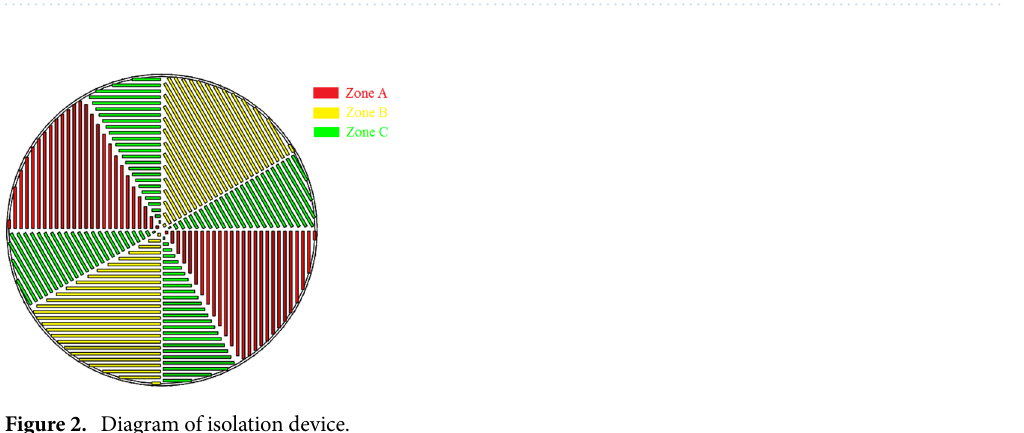
Figure 1. Model and mesh diagram of AlN-HT-MOCVD reactor. ( a ) Reactor model of the MOCVD reactor; ( b ) the whole mesh of AlN-MOCVD reactor.